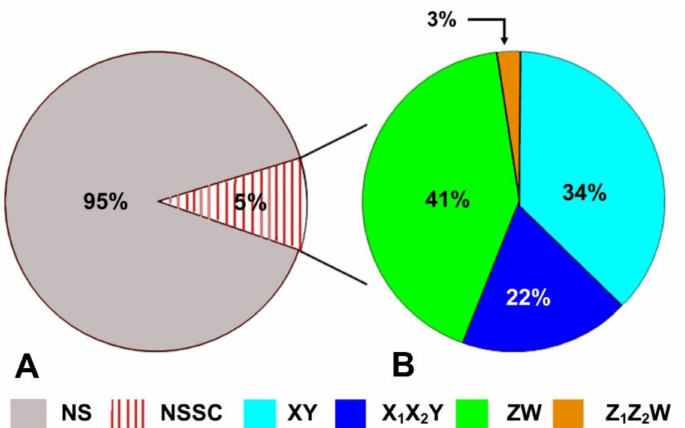
Figure 3. ( A ) NS = Number of described lizard species, NSSC = Number of lizard species with documented TSD or sex chromosome system; ( B ) Relative abundance of different sex chromosome systems in